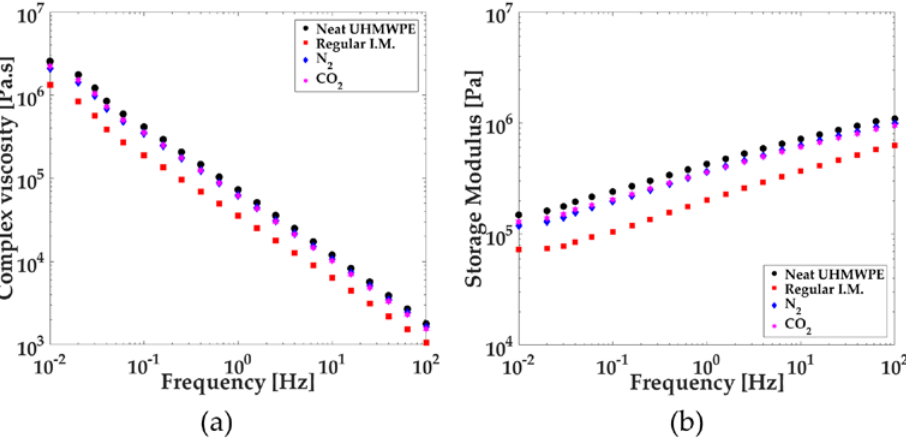
Figure 4. ( a ) Complex viscosity versus frequency; ( b ) Storage modulus versus frequency.